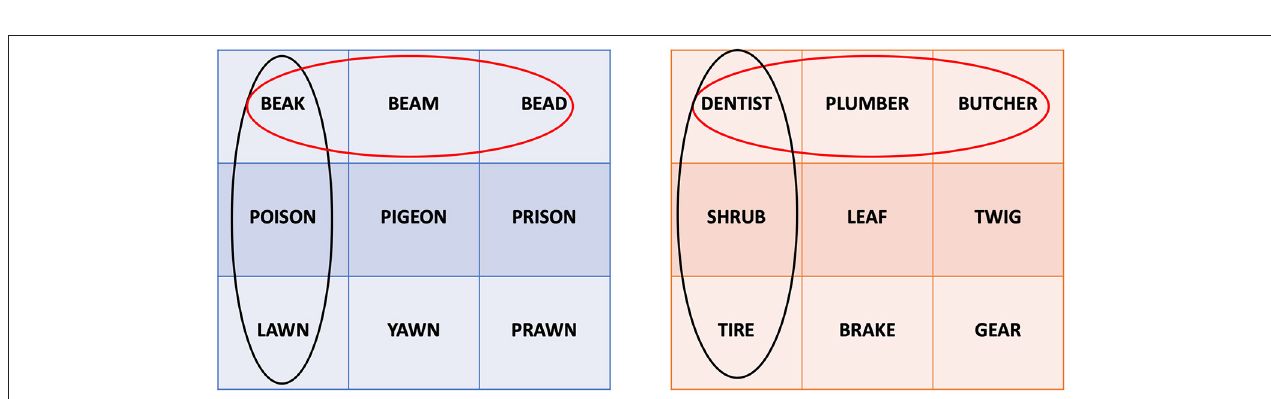
FIGURE 2 | Presentation system allowing for the between-subjects contrasting condition. The blue table on the left contains the orthographically similar words used in the experiment. The orange table on the right contains the semantically similar words used in the experiment. Red circles illustrate example triplets for the contrasted condition, black circles illustrate example triplets for the not contrasted condition. The same principle is applied to all rows and